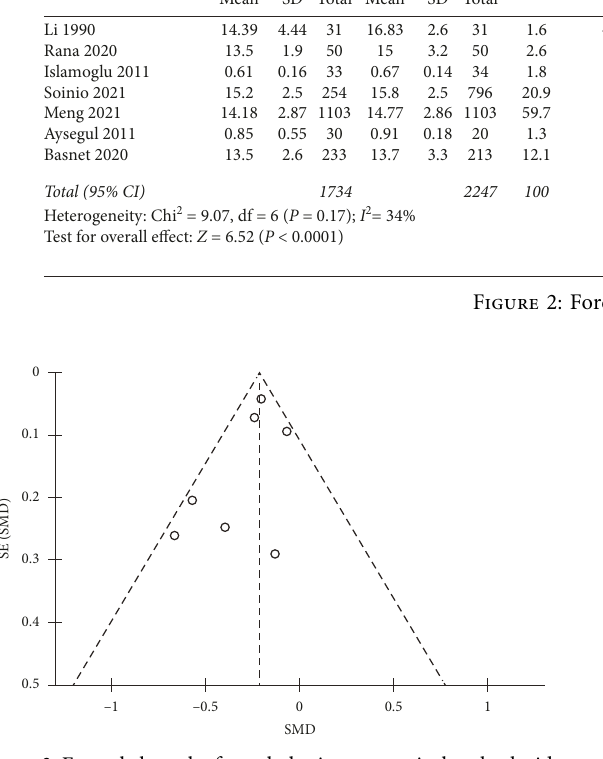
Figure 3: Funnel chart the funnel plot is symmetrical on both sides and there is no publication bias.